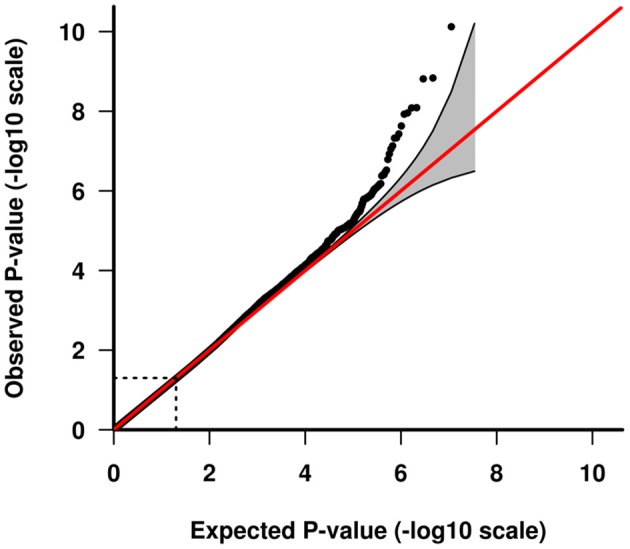
Quantile-quantile plot of GWAS analysis. The area shaded in gray indicates the 95% confidence interval under the null.